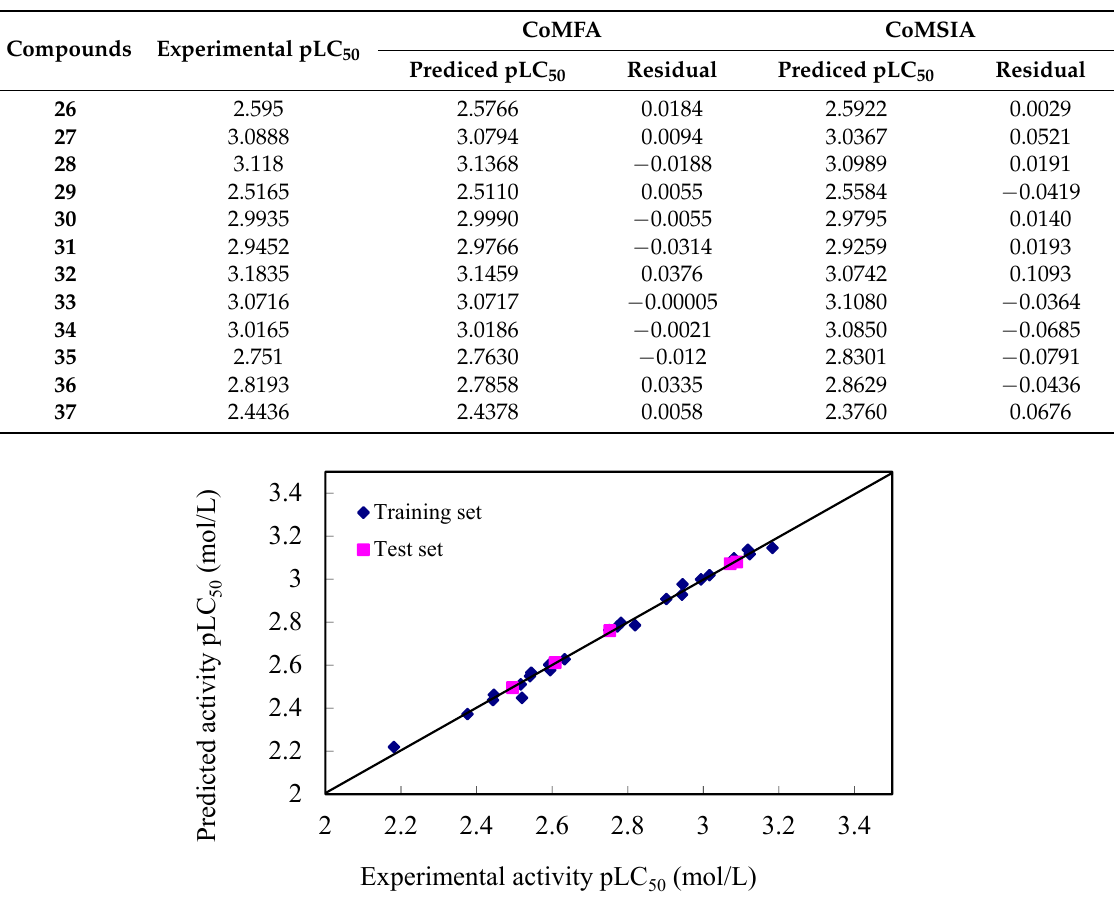
Figure 2. The plot of experimental versus calculated pLC 50 values from CoMFA analyses for the training and test set compounds.